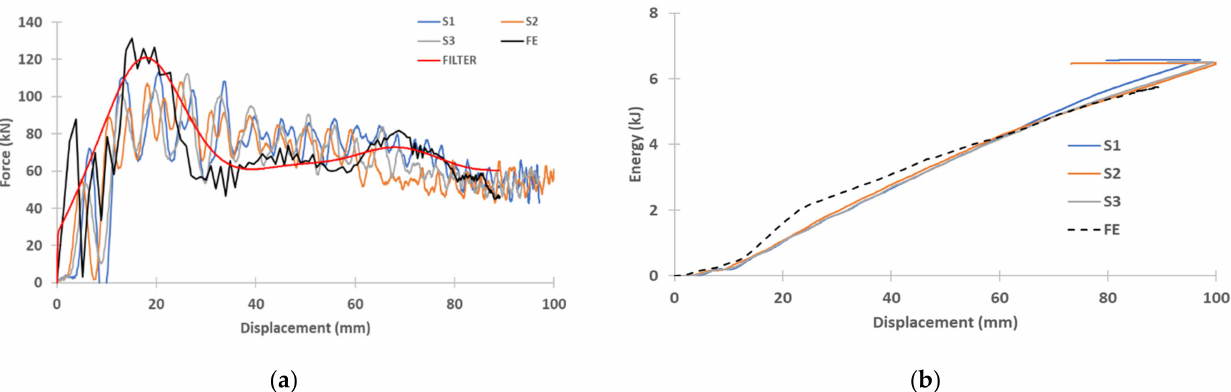
Figure 10. Hat-shaped crush at kinetic energy of 6 kJ: ( a ) Dynamic experimental and F.E load vs. displacement curves, ( b ) Dynamic experimental and F.E energy vs. displacement curves.